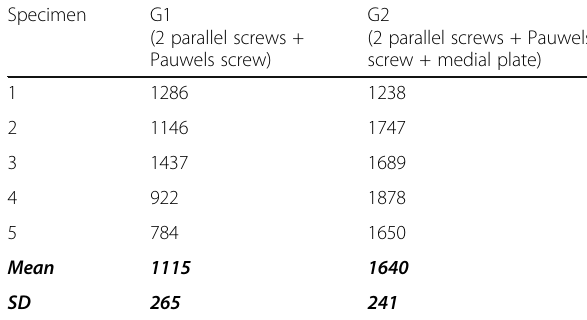
Table 4 Maximum load, in Newtons (N)